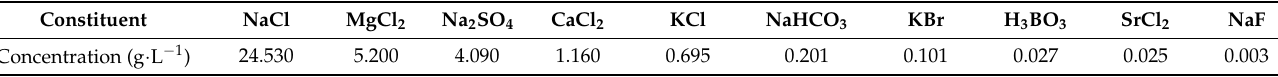
Table 4. Chemical composition of artificial seawater.